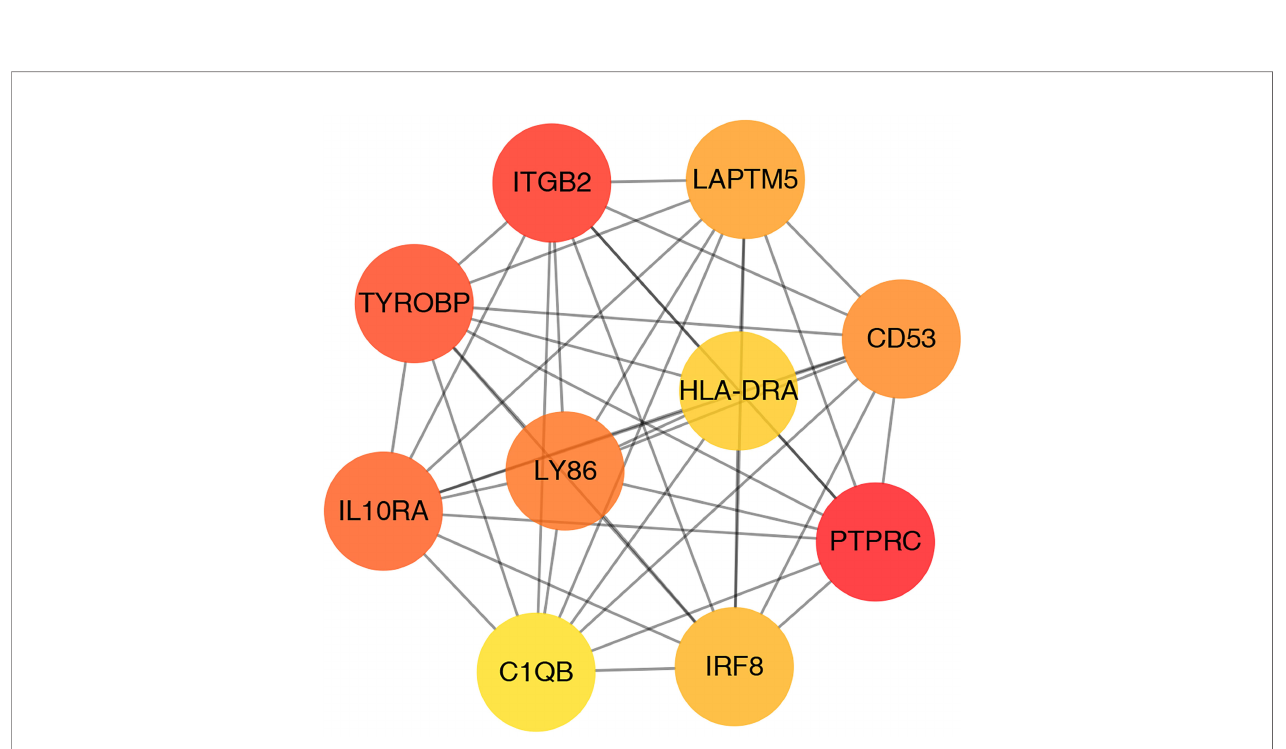
FIGURE 4 | PPI network analysis and gene cluster identi fi cation. (A) PPI network of DEGs. (B – E) Four modules extracted from the PPI network. The node represents the genes; the edge represents the relationship between